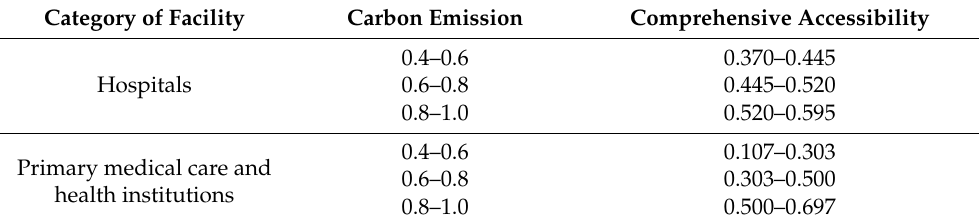
Table 19. Corresponding relation of comprehensive accessibility and medical care